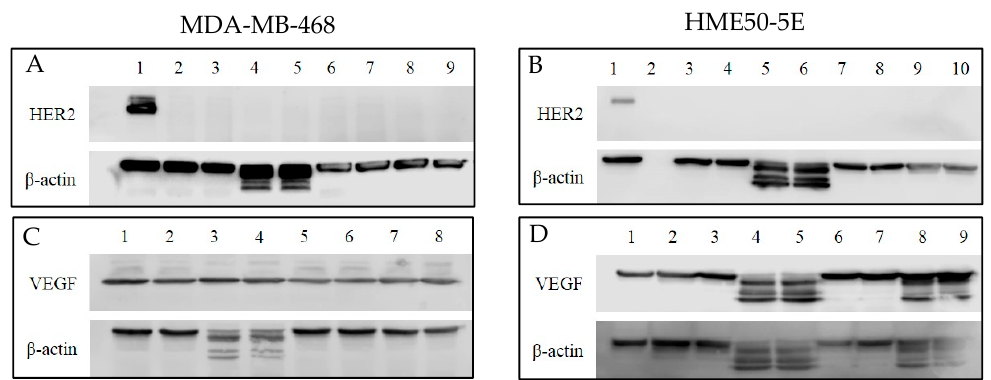
Figure 14. Western blot analysis of the expression level of human epidermal growth factor 2 (HER2) and vascular endothelial growth factor (VEGF) in MDA-MB-468 and HME50-5E cells treated with Selenite, Trastuzumab (TZ) and Selenotrastuzumab (Se-TZ). Total cell lysates were subjected to SDS-PAGE followed by Western blotting. Membranes were probed with the anti-HER2, anti-VEGF, or anti β -actin antibodies followed by peroxidase conjugated rabbit anti-mouse antibodies and visualization was performed by the enhanced chemiluminescence (ECL) detection system. ( A ) HER2 and MDA-MD-468 cells. Lane 1: BT474 as HER2 positive loading control; Lanes 2 and 3: Control; Lanes 4 and 5: Selenite (2 µ g as Se) treatments; Lanes 6 and 7: TZ (26.22 µ g as protein) treatments;